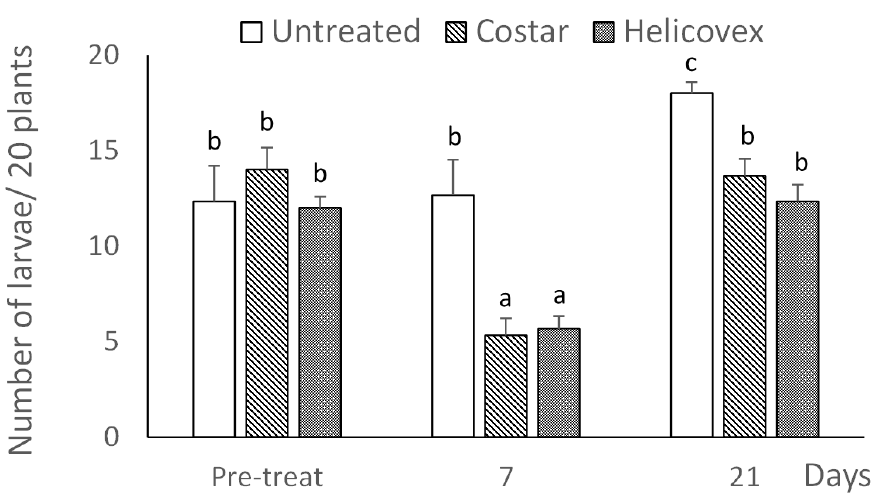
Figure 4. Density (mean ± SD) of H. armigera larvae assessed on plots before (Pre-treat) and after application of bioinsecticidal products based on Btk and Ha NPV. Different letters above bars indicate significant differences among means (ANOVA Mixed Proc., p <